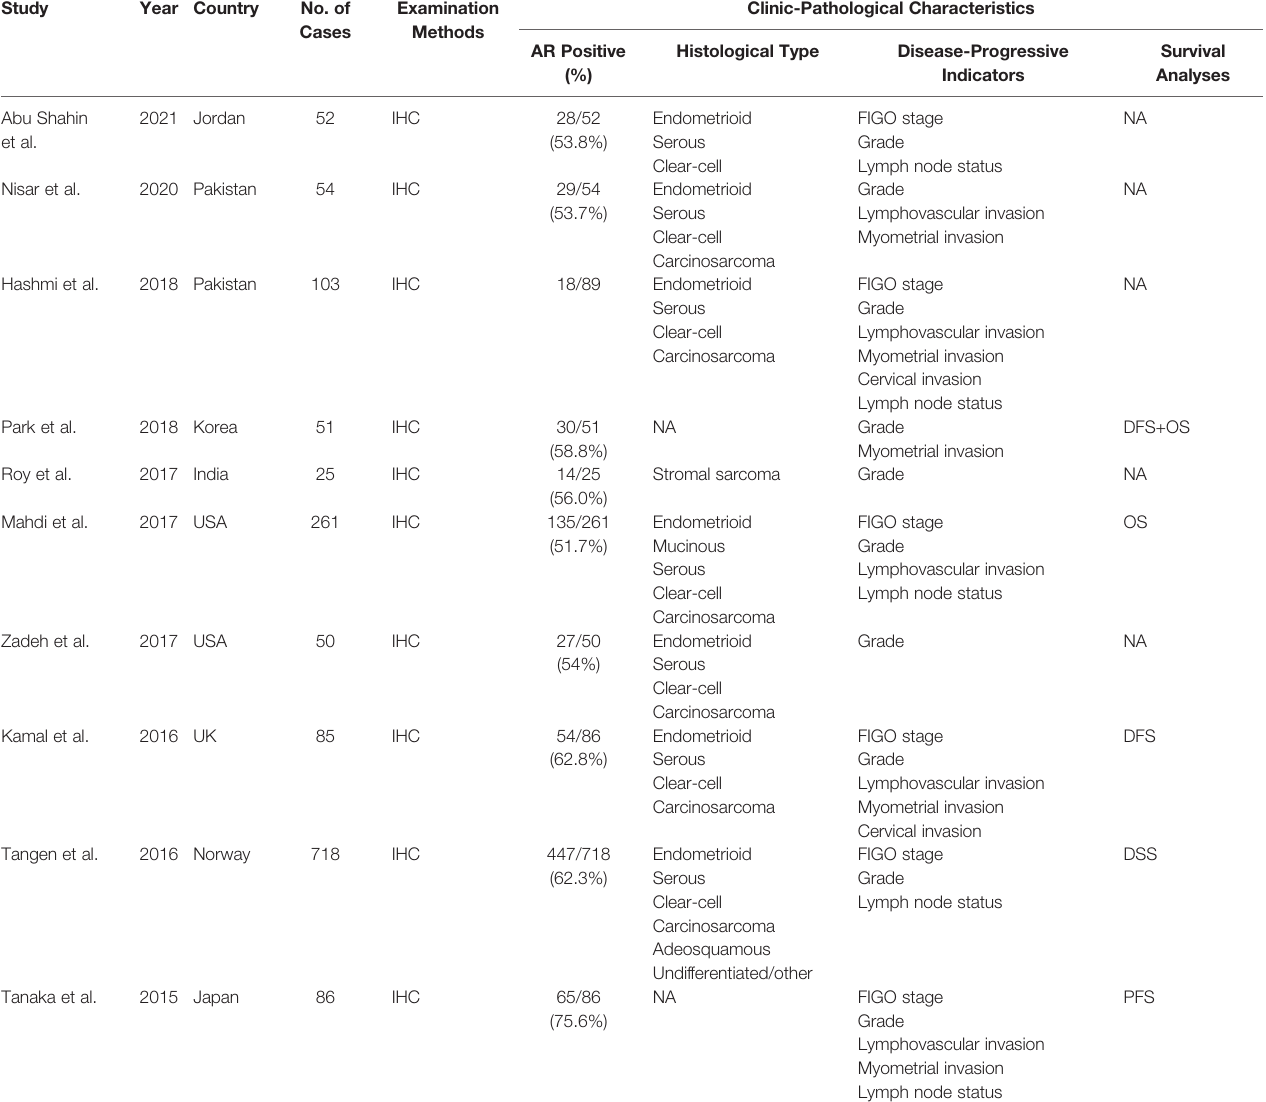
TABLE 1 | Characteristics of the included studies.